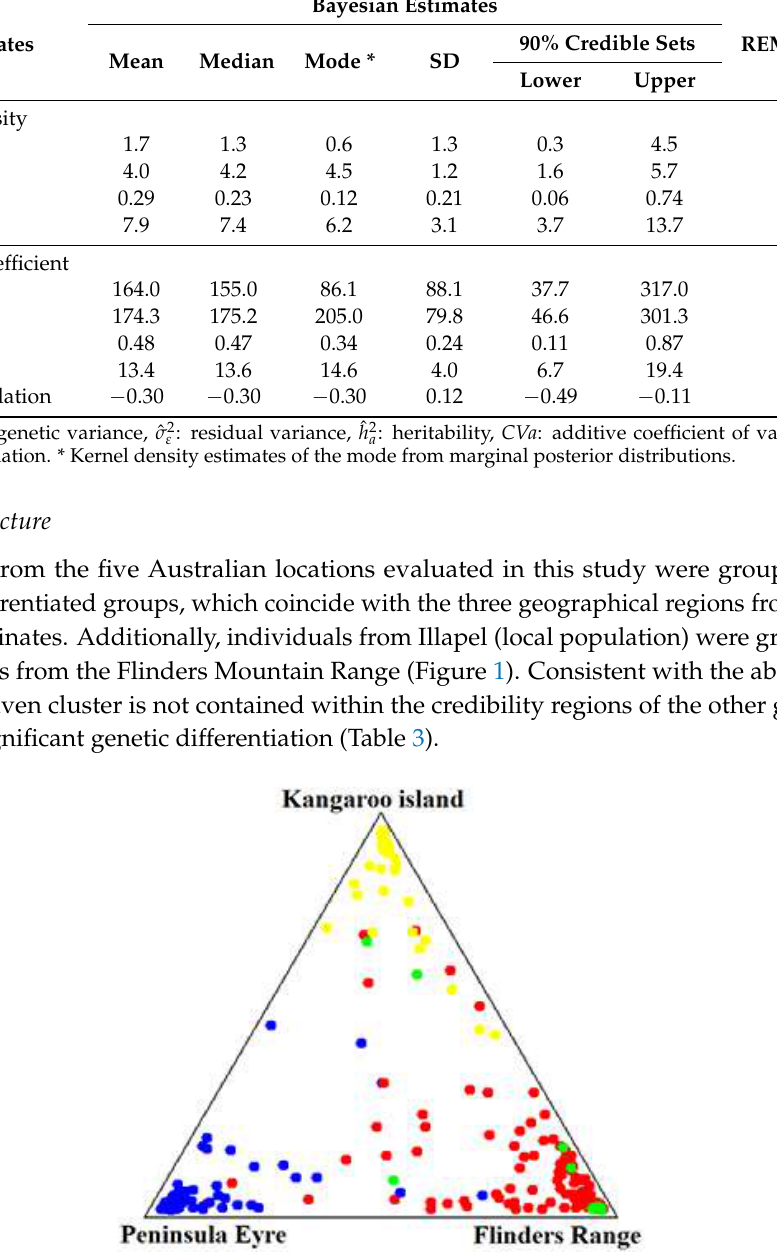
Figure 1. Bayesian clustering approach showing three groups genetically differentiated, according to the geographical origin of E. cladocalyx in Australia. The blue dots correspond to the populations from Marble Range and Cowell, the yellow dots correspond to the population from Flinders Chase, the red dots correspond to the populations from Wirrabara and Remarkable, and the green dots correspond to the local population taken from Illapel, Chile.